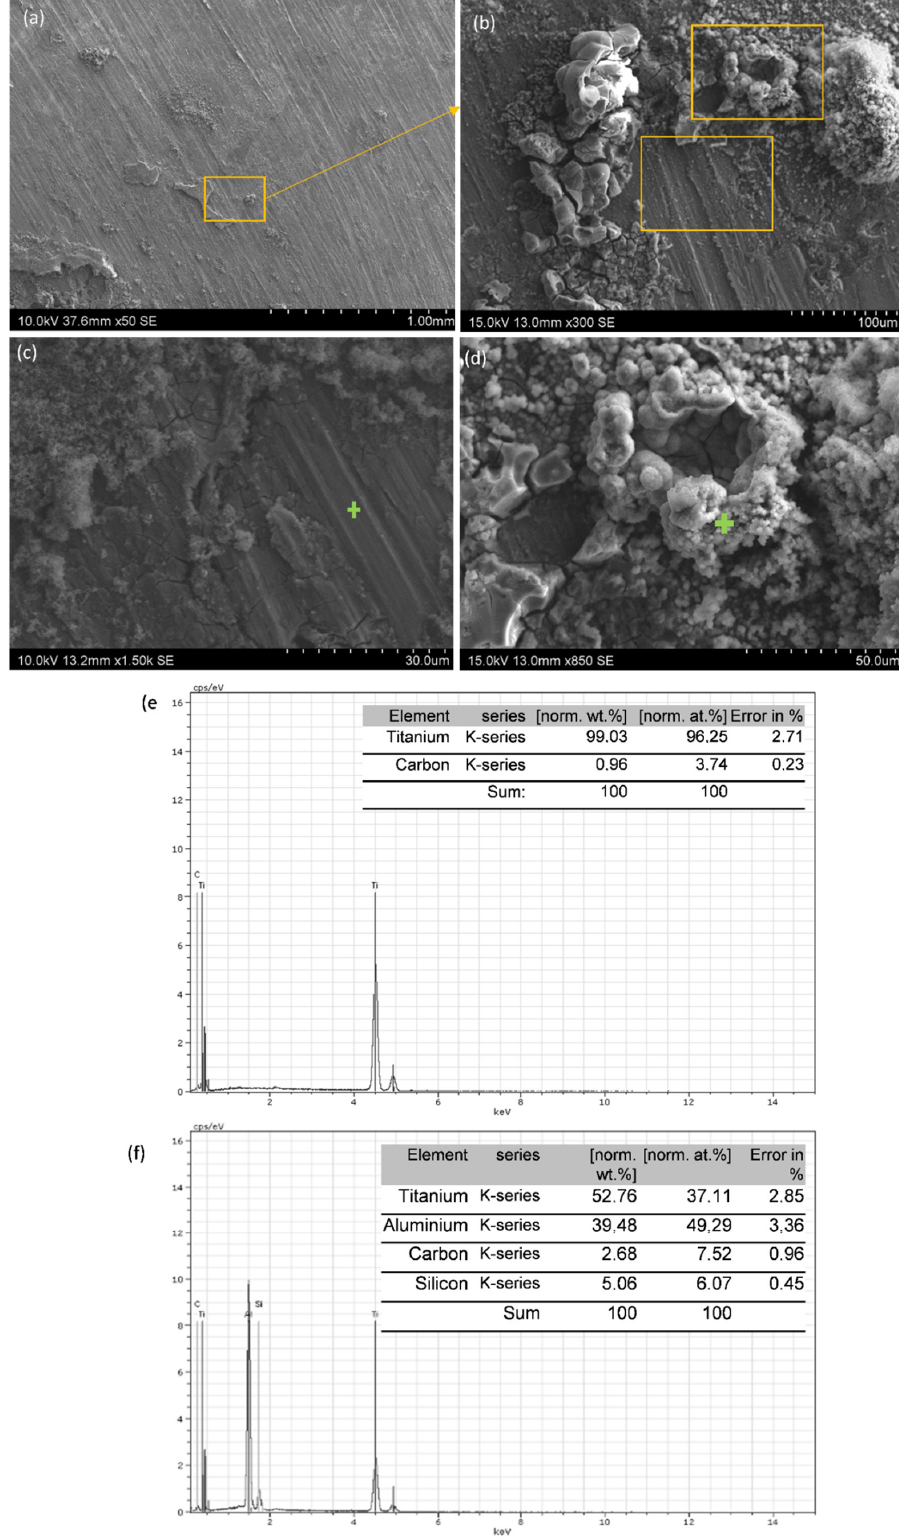
Figure 7. SEM images of the surface of the Al12Si20Ti/SiC coating after 168 h of immersion in 3.5 wt.% NaCl: ( a ) general view; ( b ) detail of the morphology of the coating; ( c , d ) details of ( b ); ( e ) EDS analysis of point marked in ( c ); and ( f ) EDS analysis of point marked in ( d ).